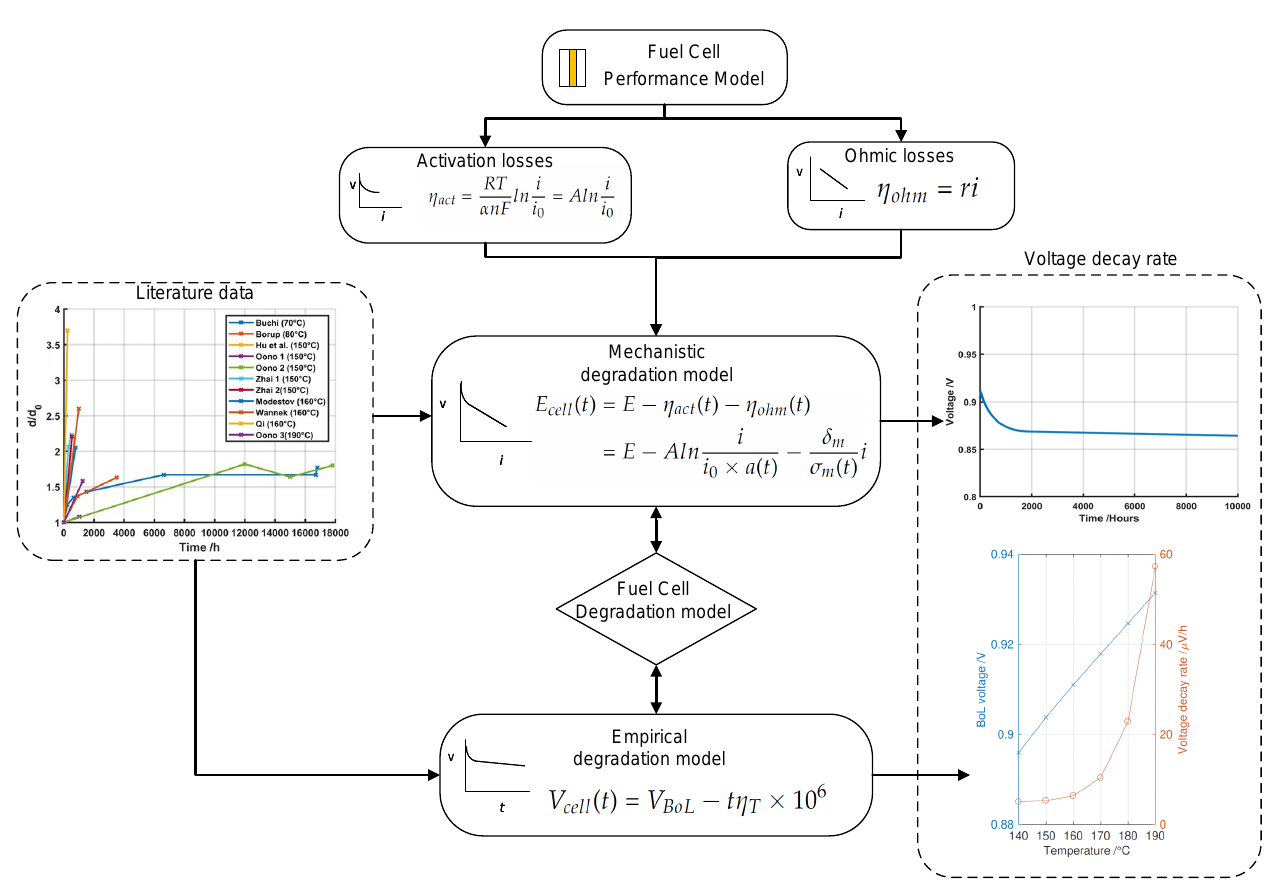
Figure 1. A flow chart of the modeling approach in the current